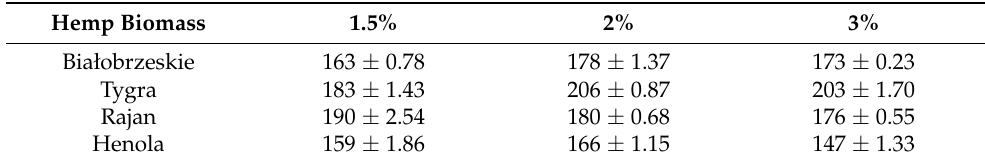
Table 2. The amount of reducing sugars (mg · g − 1 ) released after an enzymatic test depending on the NaOH